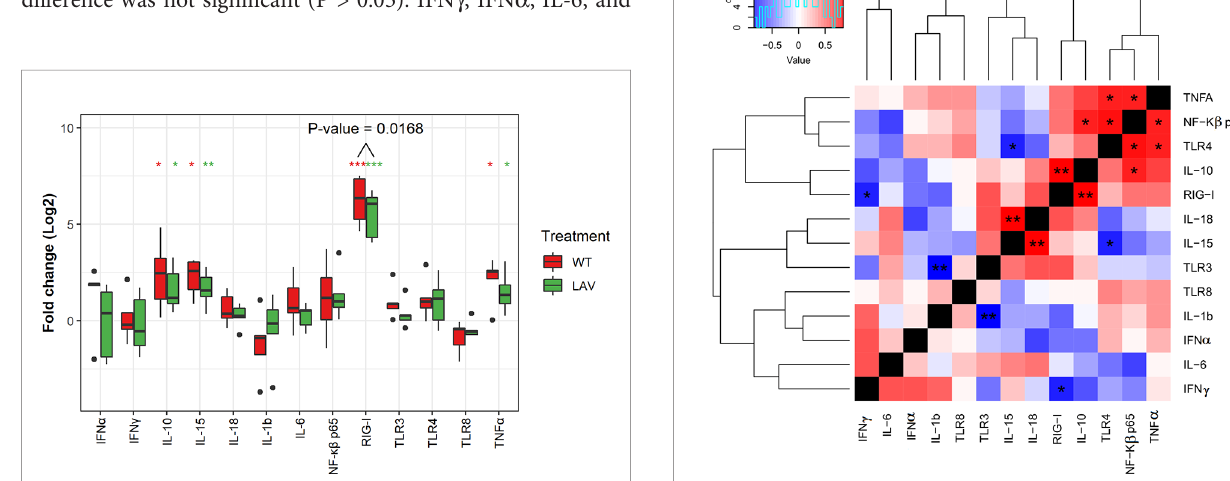
FIGURE 2 | Box plots representing the differential expression of mRNA of thirteen genes. The expression of RIG-1, IL-10, IL-15 and TNF a were signi fi cantly upregulated. Note that the expression RIG-1 was signi fi cantly higher in WT as compared to LAV. Data represent the Log2 FC of fi ve independent experiments. Signi fi cance level was set at P value (*p<0.05, **p<0.001, ***p<0.0001).